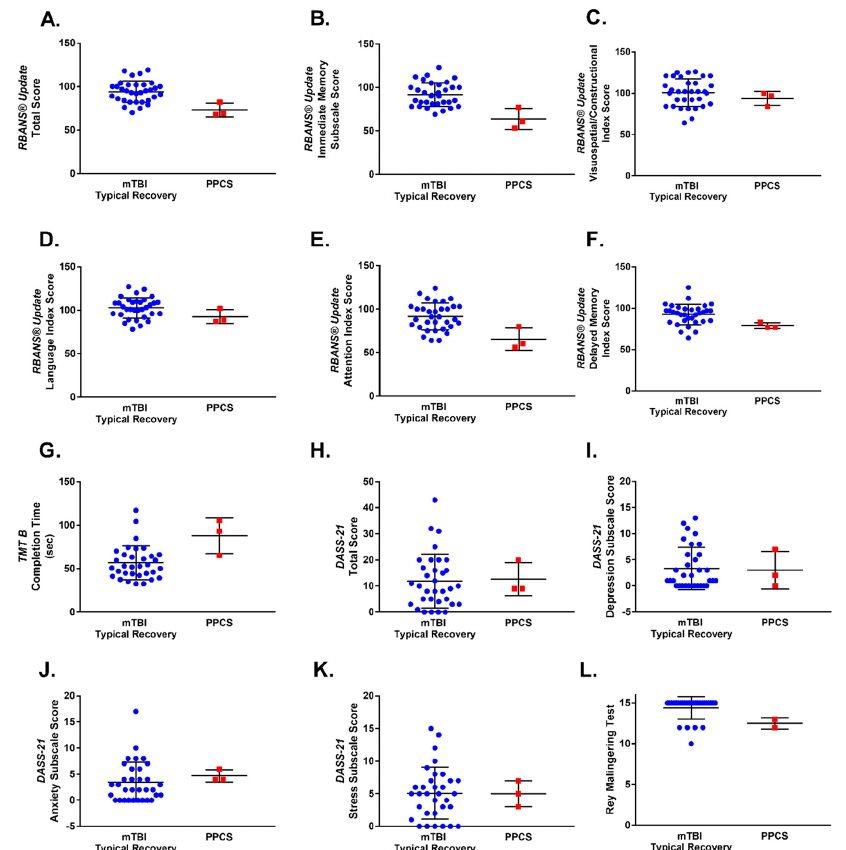
Figure 3. Scatterplots depicting patient performance on neuropsychological outcomes, as measured at presentation to the ED. Mean and standard deviation are shown for mTBI typical recovery and PPCS groups for all neuropsychological outcomes assessed, which were as follows: ( A ) the RBANS ® Update Total Score, ( B ) RBANS ® Update Immediate Memory subscale, ( C ) RBANS ® Update Visual/Constructional subscale, ( D ) RBANS ® Update Language subscale, ( E ) RBANS ® Update Attention subscale, ( F ) RBANS ® Update Delayed Memory subscale, ( G ) TMT B, ( H ) DASS-21 Total Score, ( I ) DASS-21 Depression subscale, ( J ) DASS-21 Anxiety subscale, ( K ) DASS-21 Stress subscale, ( L ) Rey Malingering Test.